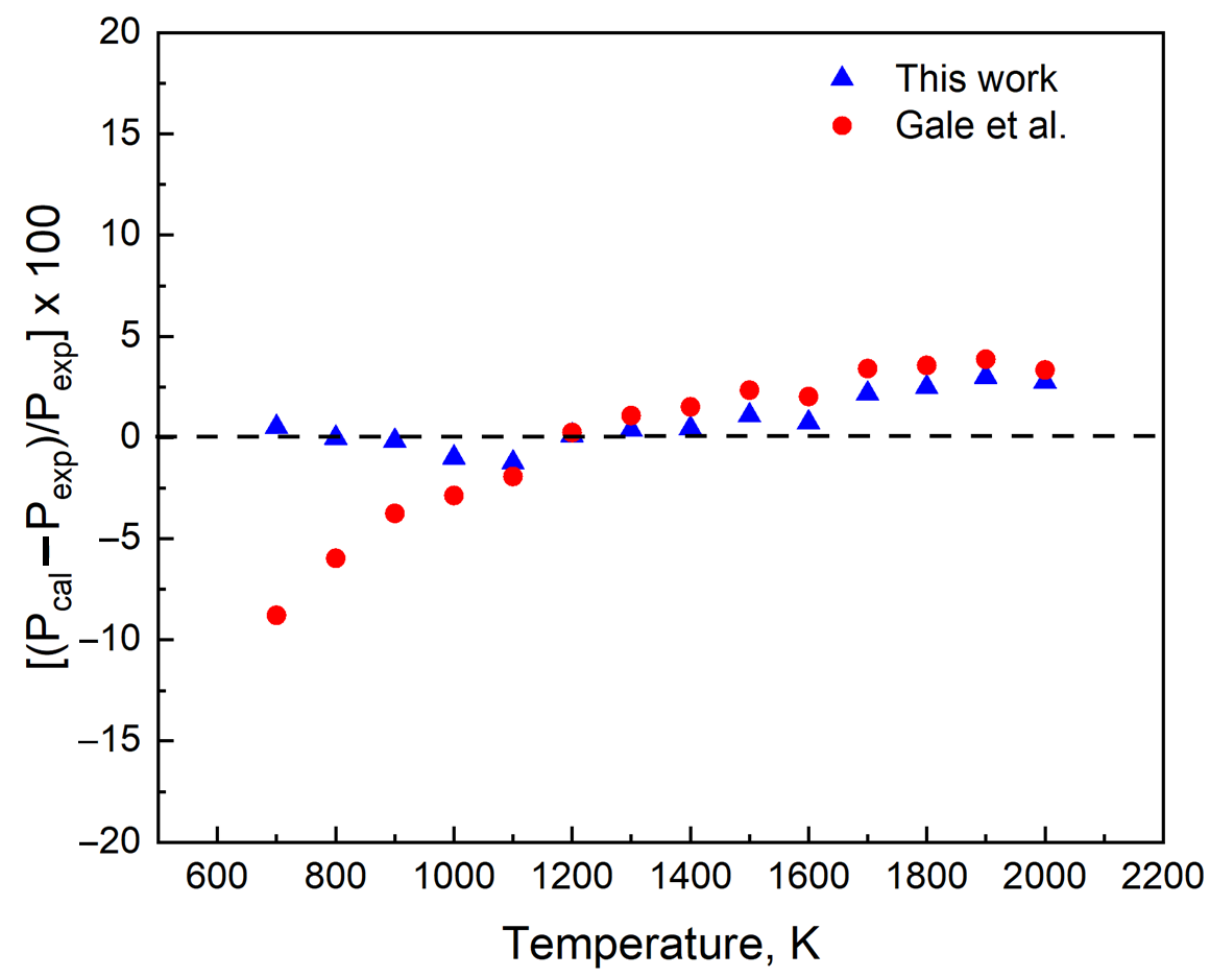
Figure 3. This is a wide figure. Figure 7. The differences in the vapor pressure data of the recommended relation and that using the previous relation Gale et al. [14] from the experimental data of Hultgren et al. [12] for